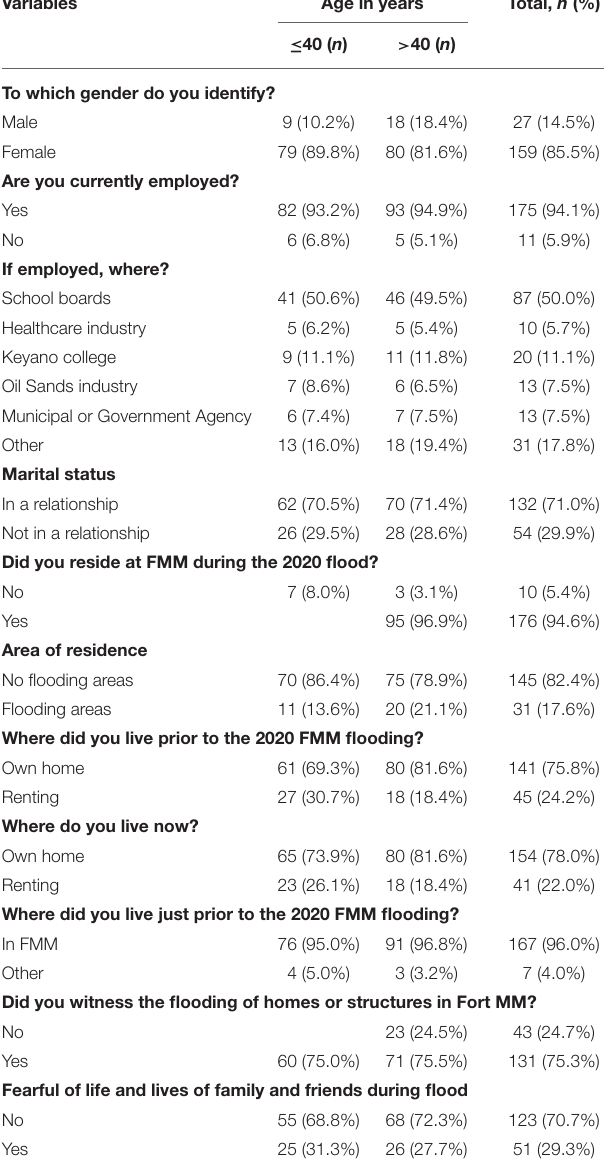
TABLE 1 | Demographic and flood-related variables by age of